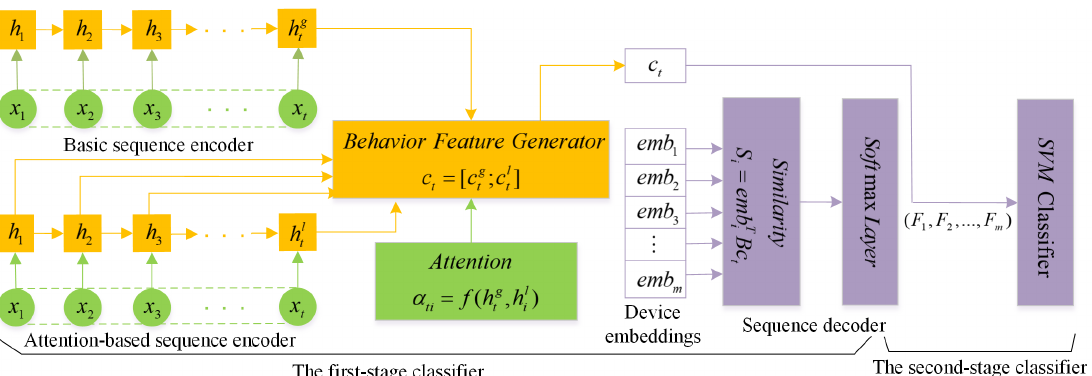
Figure 2. The graphical model of SPC, where the first-stage classifier contains attention-based HRNN while the second-stage classifier is SVM. Note that the sequence feature c t is represented by the concatenation of vectors c g and c l , the output F = [ f 1 , f 2 , . . . , f t − 1 , f t ] means the learned student t t sequential